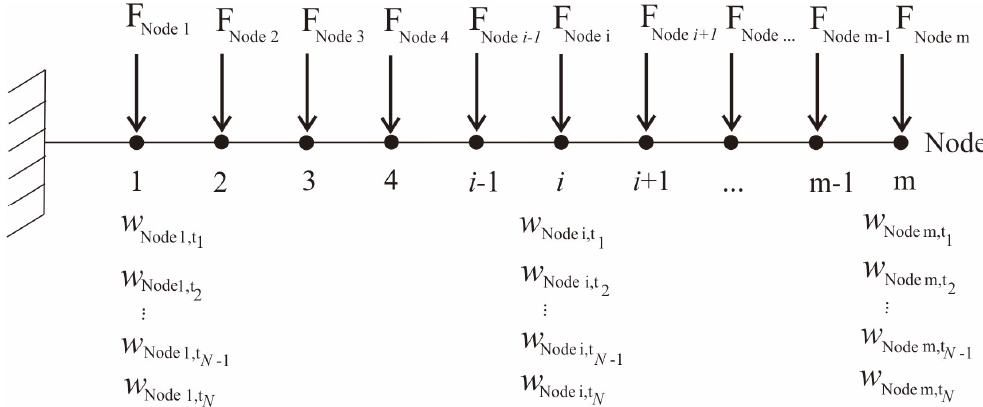
Figure 2. the magnitude of displacement and external force acting on each specified node. Figure 2. The magnitude of displacement and external force acting on each specified